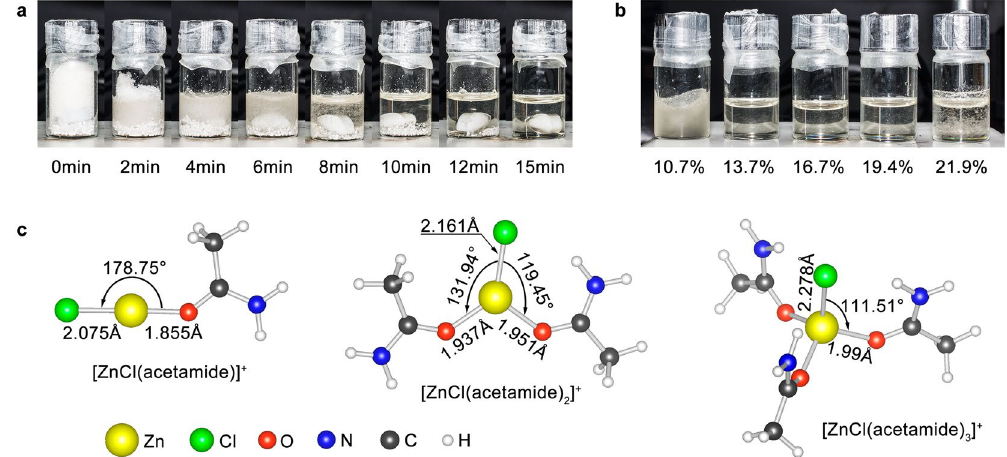
Figure 1. ( a ) Digital images showing the formation process with time of Zn eutectic solvent; ( b ) digital images showing the effect of different ZnCl 2 molar fraction on the formation of Zn eutectic solvent; ( c ) optimized coordination geometries of Zn(II) complexes in the eutectic